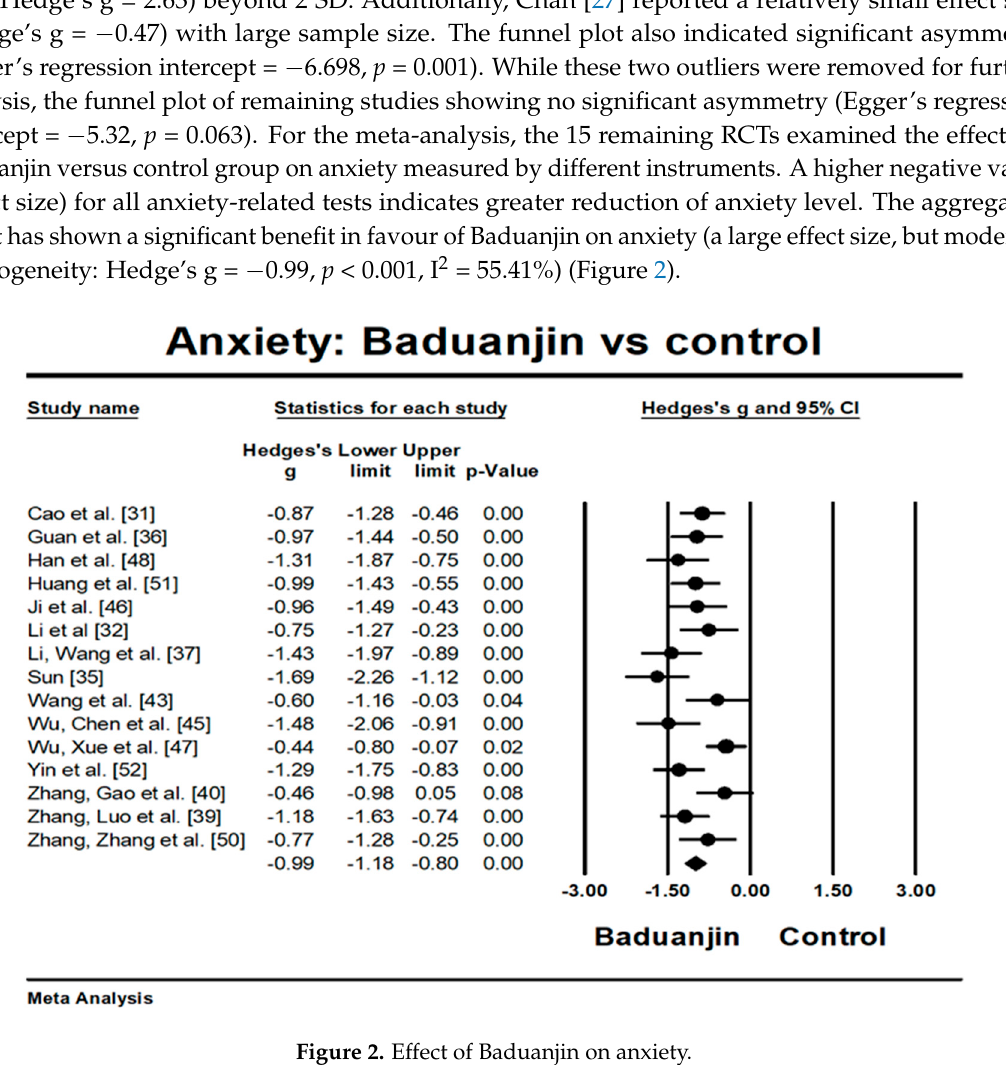
Figure 2. Effect of Baduanjin on anxiety.